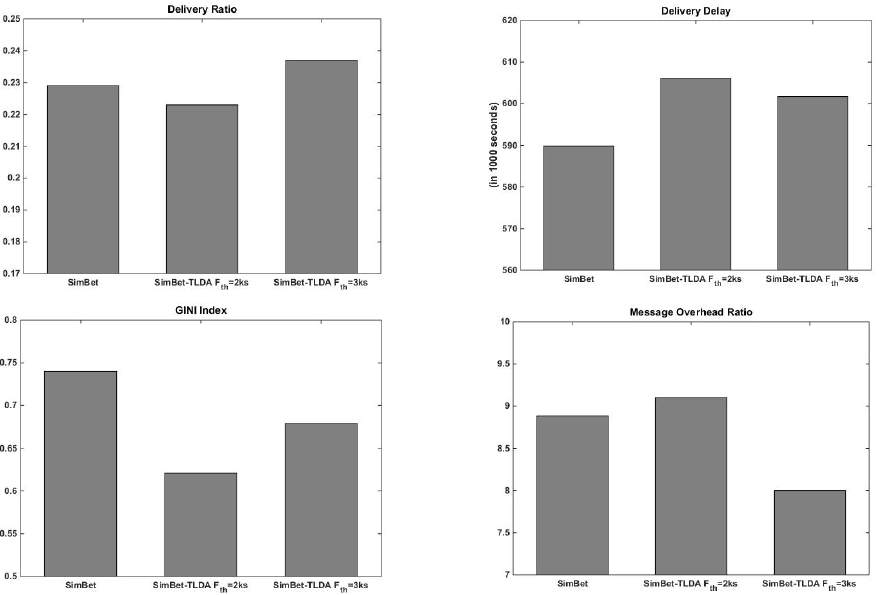
Figure 13. Performance evaluation of SimBet and SimBet-TLDA ( ξ = 0.8) for the Sassy mobility scenario. Similar with the case in Reality, here SimBet-TLDA also improves the traffic fairness in the network (indicated by the reduced GINI index), while keeping other delivery performances as high as those of SimBet.